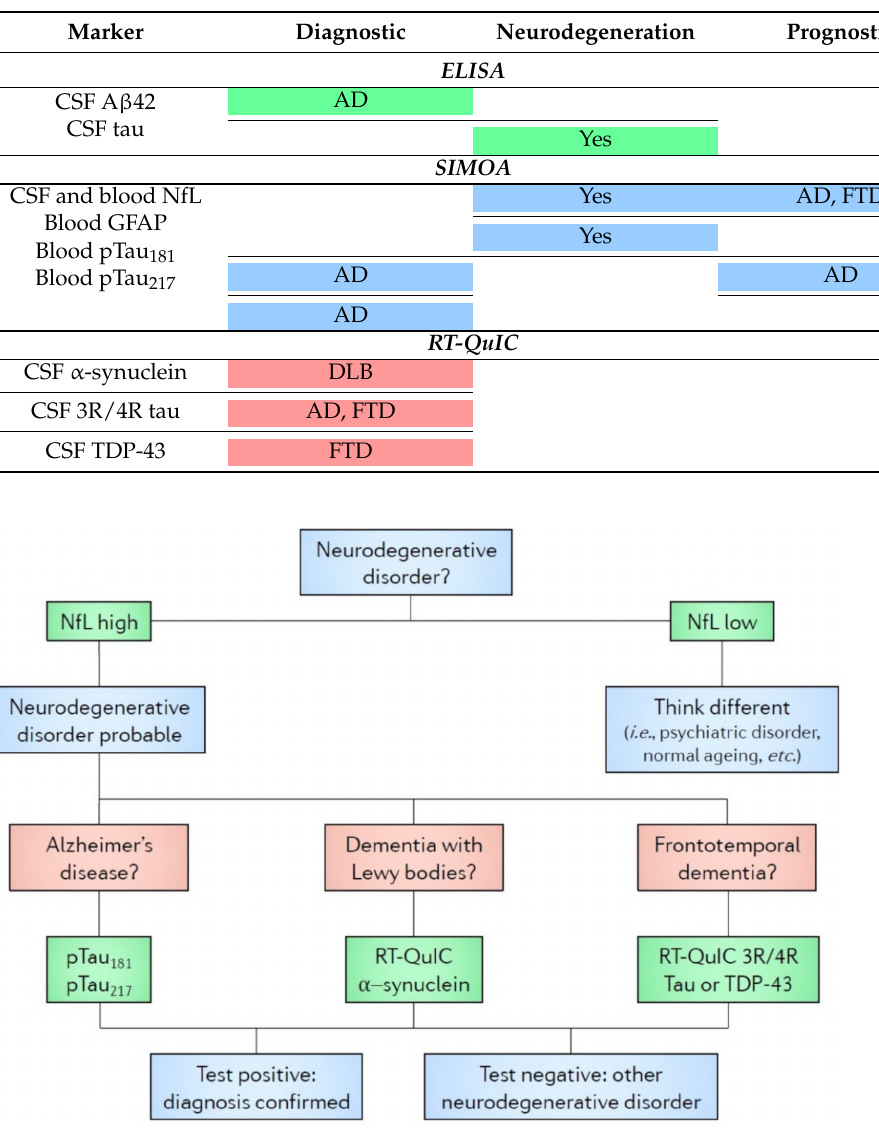
Table 1. The conventional and novel potential biomarkers for neurodegenerative dementia. A β 42, beta-amyloid 42; AD, Alzheimer’s disease; CSF, cerebrospinal fluid; DLB, dementia with Lewy bodies; ELISA, enzyme-linked immunosorbent assay; FTD, frontotemporal dementia; GFAP, glial fibrillary acidic protein; NfL, neurofilament light chain; pTau181, Tau phosphorylated at threonine 181; pTau217, Tau phosphorylated at threonine 217; RT-QuIC, real-time quaking-induced conversion; SIMOA,